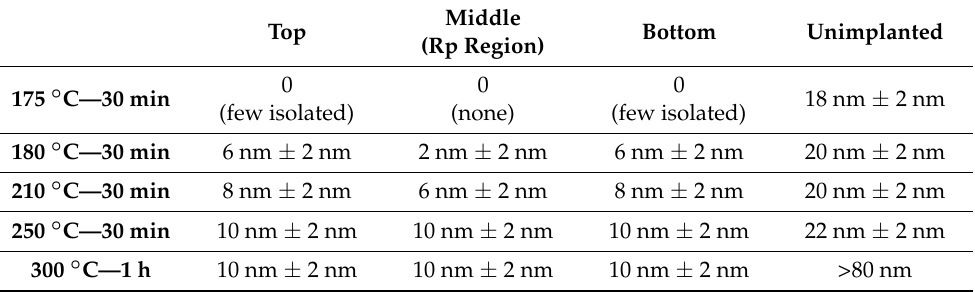
Table 2. Mean GST-225 grain sizes as a function of depth position in the layer and for different anneal- ing temperatures. The BF and DF images used for data extraction are shown in the Supplementary Materials Figure S3. Middle Bottom Top (Rp Region)